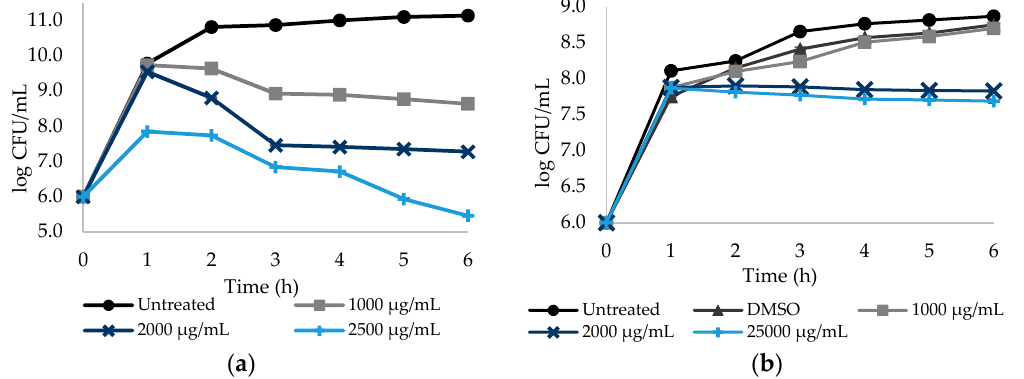
Figure 2. Dose–response curves. The y -axis reports the log CFU/mL of S. aureus planktonic cells, while the x -axis reports the period of 6 h of exposure to the NSAIDs: ( a ) DCF (diclofenac sodium) at three different concentrations (1/2× MIC, MIC and a concentration above the MIC), untreated with DMSO; ( b ) ASA (acetylsalicylic acid) at three different concentrations (1/2× MIC, MIC and a concentration above the MIC) treated with DMSO. Cells without NSAIDs and cells with DMSO were used as negative controls. Mean values ± SD are represented.